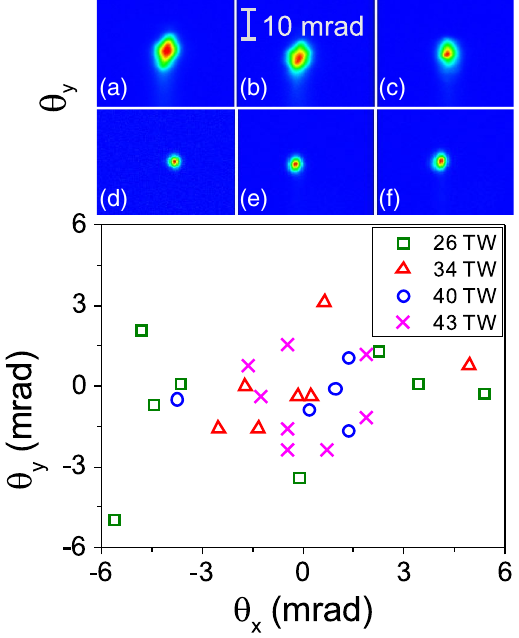
FIG. 2. Images of electron beam on LANEX without disper- sion in magnetic spectrometer; the color scale is normalized for each shot. (a)–(c) Electron beams obtained with 26 TW laser power and plasma density 1 : 2 (cid:2) 10 19 cm (cid:3) 3 . The beam diver- gence is 6 mrad (FWHM). (d)–(f) Electron beams obtained with 43 TW laser power and plasma density 7 : 2 (cid:2) 10 18 cm (cid:3) 3 . The beam divergence is 3 mrad (FWHM). The plot at the bottom shows the angular position of the undeflected beam (calculated from the centroid) for a laser power in the range between 26 and 43 TW, and plasma density in the range 6 (cid:2) 10 18 – 2 : 4 (cid:2) 10 19 cm (cid:3) 3 . Symbols correspond to the following values of laser power and electron density: ( h ) 26 TW, 9 (cid:2) 10 18 – 2 : 4 (cid:2) 10 19 cm (cid:3) 3 , ( 4 ) 34 TW, 8 (cid:2) 10 18 – 1 : 2 (cid:2) 10 19 cm (cid:3) 3 , ( (cid:6) ) 40 TW, 7 : 2 (cid:2) 10 18 – 1 : 2 (cid:2) 10 19 cm (cid:3) 3 , and ( (cid:2) ) 43 TW, 6 (cid:2) 10 18 – 9 (cid:2) 10 18 cm (cid:3) 3 . Over the entire range of variation of the laser and plasma parameters, lateral deflection of the beam (the beam pointing) does not exceed 4